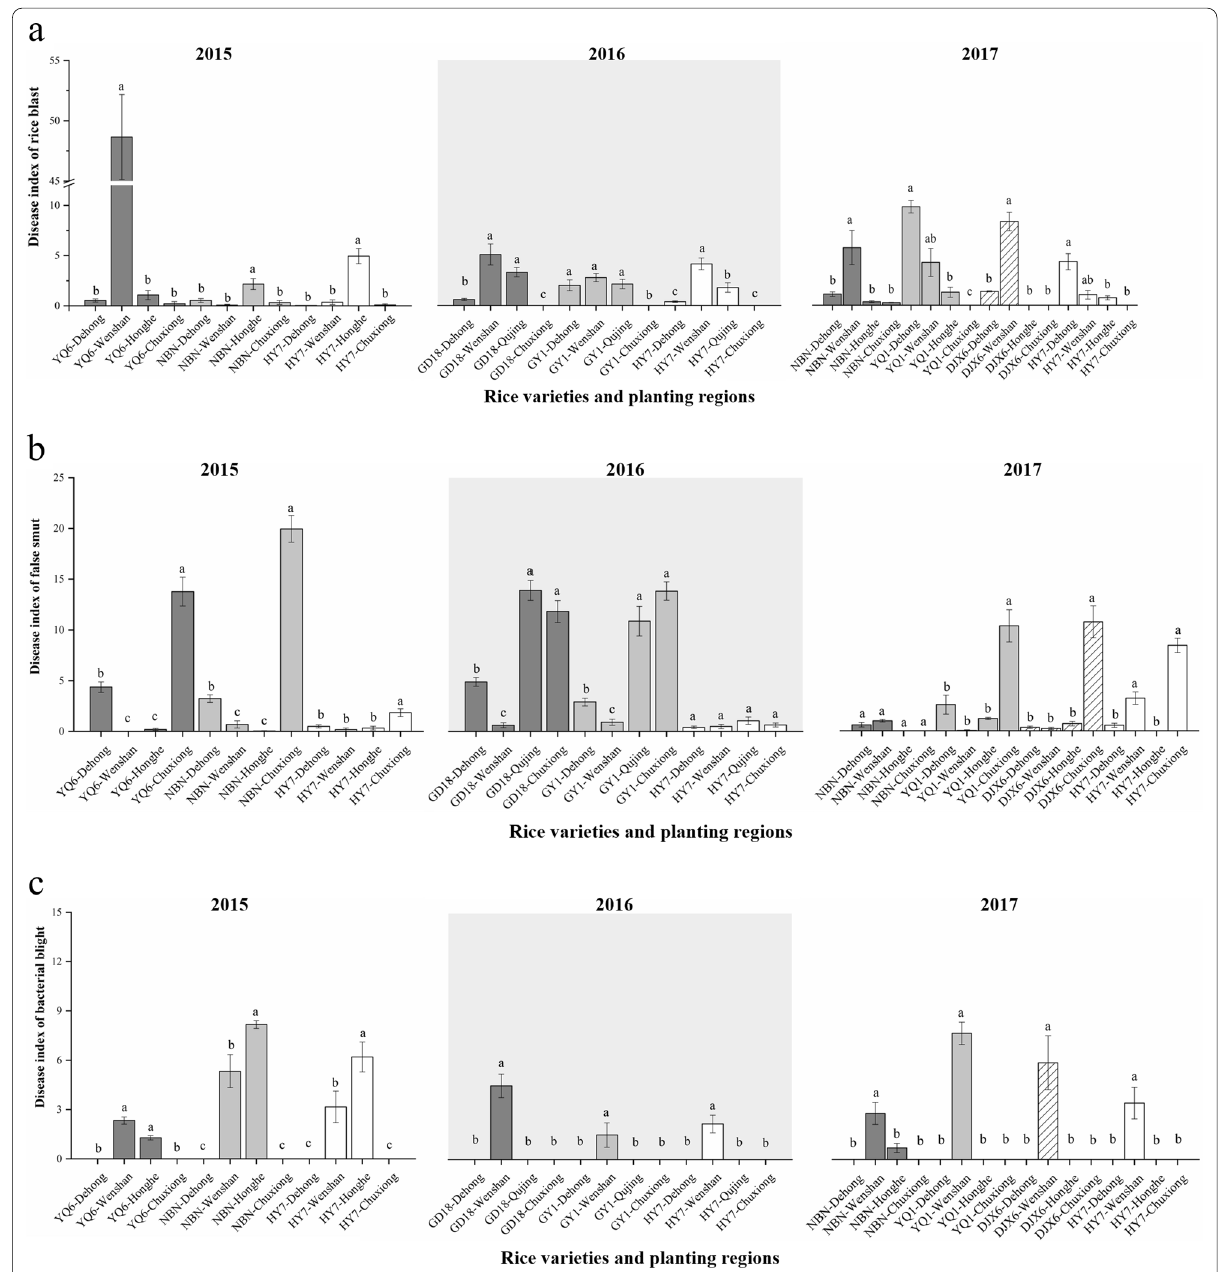
Fig. 4 The occurrence of three main rice diseases on multi‑genotype varieties in different rice‑planting regions. Disease indexes of rice blast ( a ), rice false smut ( b ) and rice bacterial blight ( c ). Six multi‑genotype varieties (DJX6, GD18, GY1, YQ1, YQ6, NBN) were used for field experiments during 2015–2017. HongYou‑7 (HY7), a local high‑yielding and disease‑resistant variety was used as the control variety. DI, disease index. Different letters above the columns indicate significant differences at P < 0.05 based on Duncan’s test (n =